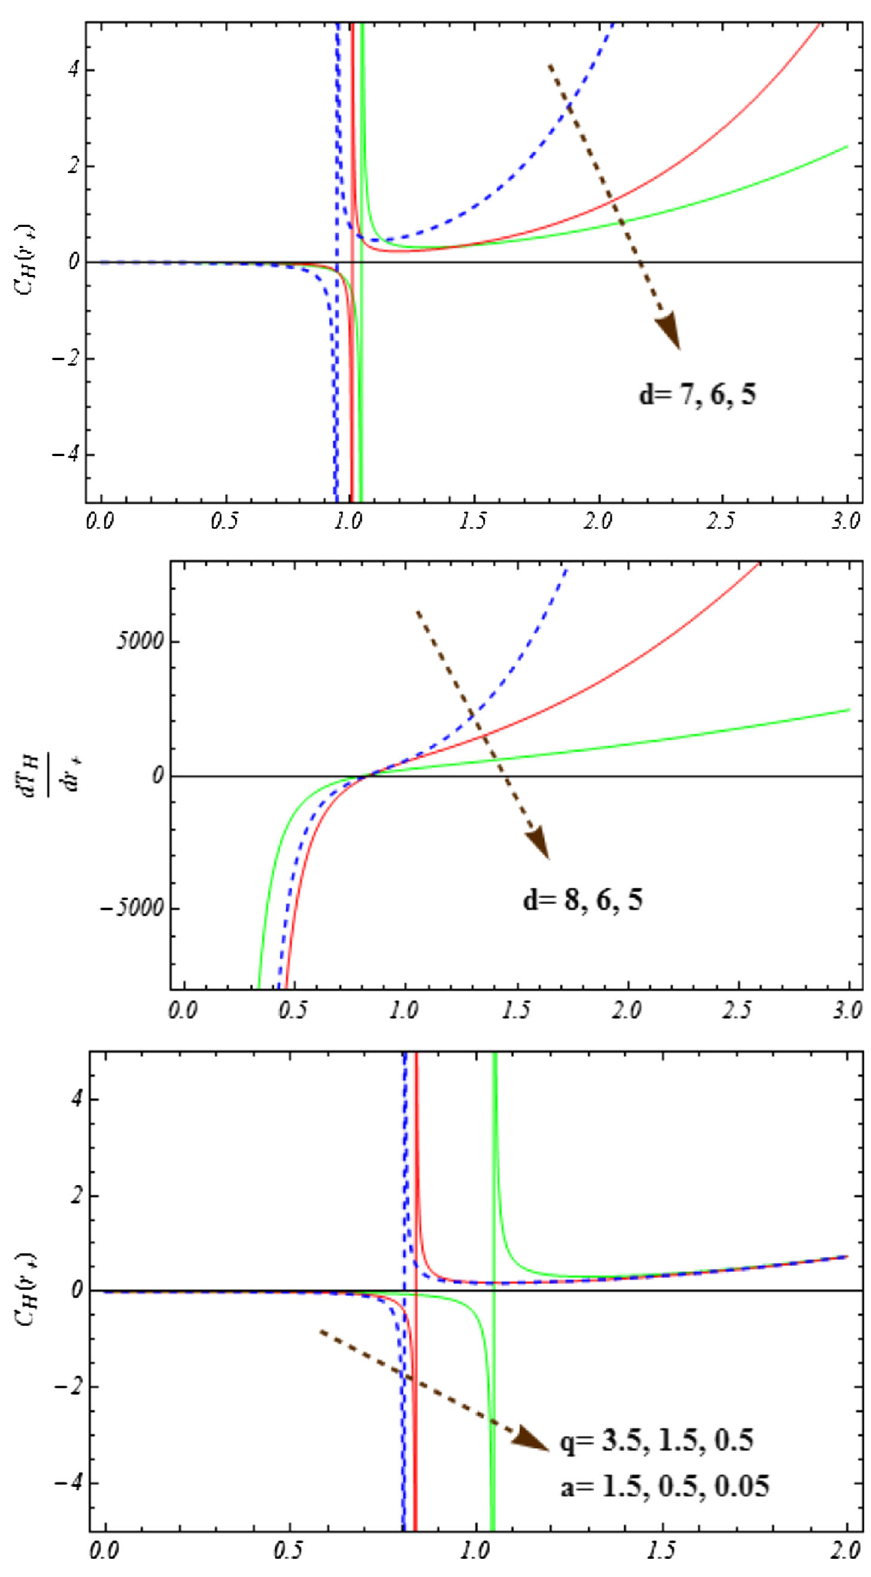
Fig. 7 The plot of specific heat C H (Eq. (3.15)) vs r + for fixed values of l = 1, G = 1, δ = 10, ω = − 0 . 7, d , 2 n − 1 q (cid:13) = 100, q = 0 . 2, a = 0 . 05 d − 2 and H A = 0 . 5